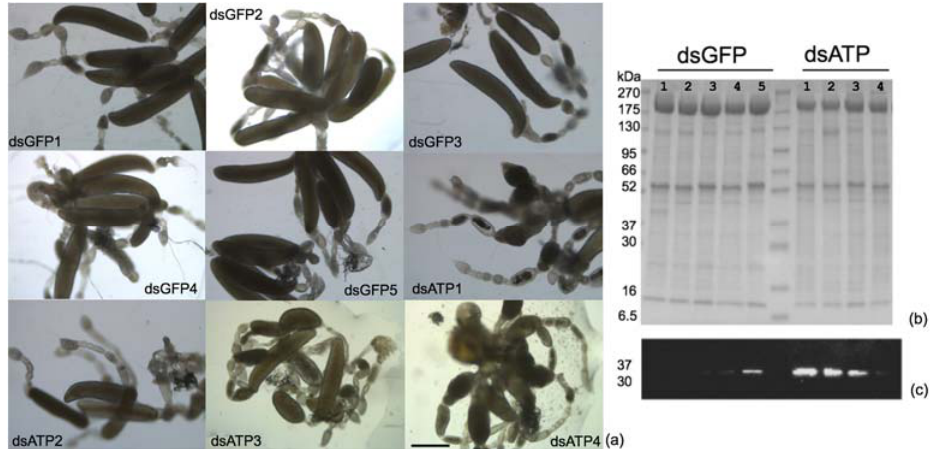
Figure 3. Images of ovaries ( a ) of Scaphoideus titanus females collected at 20 days post injection with dsRNAs (80 ng/ insect) targeting green fluorescent protein, (dsGFP1 to 5), used as the control, or ATP synthase β (dsATP1 to 4) observed in bright field. Bar = 500 µ m. Mono-dimensional SDS-PAGE ( b ) and corresponding western blots developed with anti-cathepsin L primary antibody ( c ) of total proteins from the same ovary samples observed in ( a ). Molecular weights of Sharpmass VII Prestained Protein Marker (EuroClone) are indicated in KDalton.